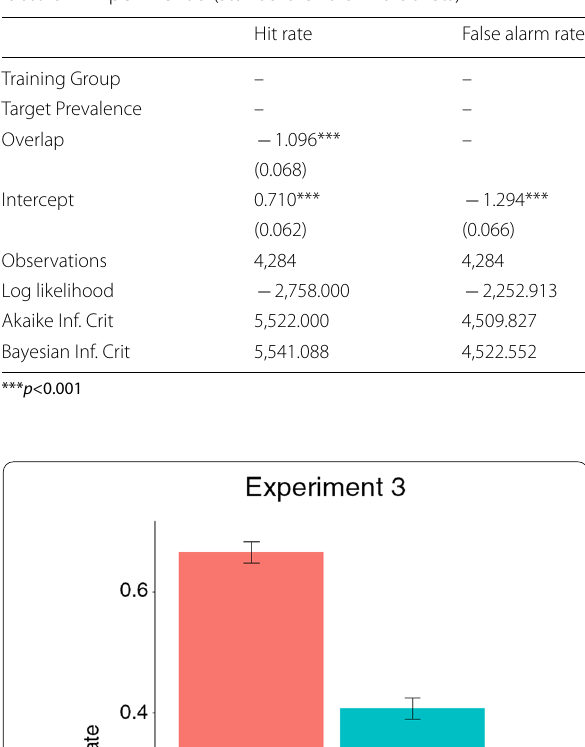
Table 4 Generalised linear mixed‑effects models comparing hit rate and false alarm rate including training group and overlap as factors in Experiment 3 (standard errors in brackets)